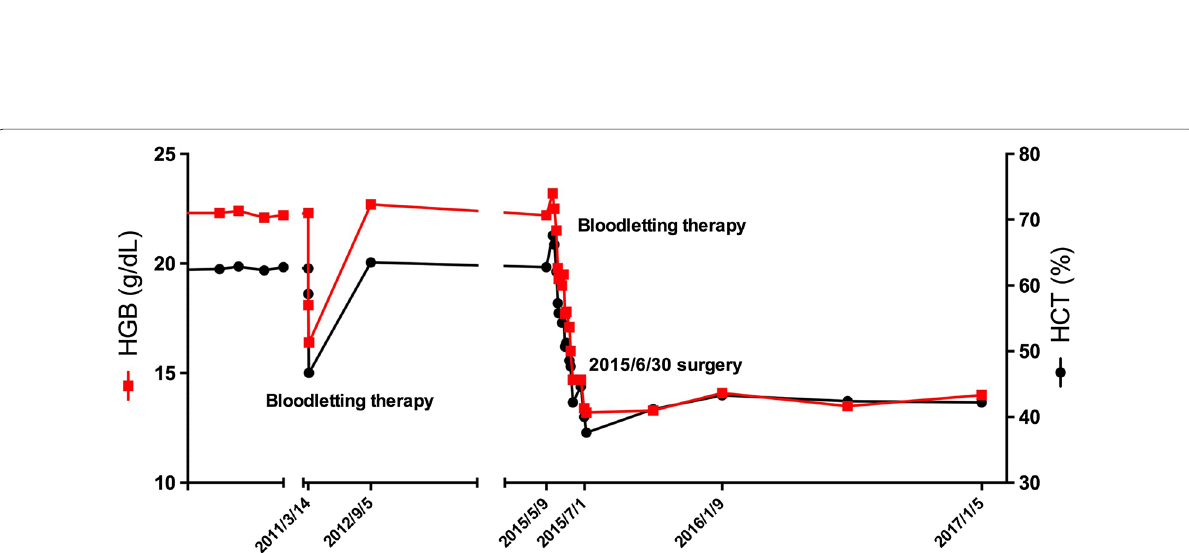
Fig. 5 Changes in the patient’s serum hemoglobin (HGB) and hematocrit (HCT) levels before and after surgery. The patient’s HGB and HCT remained at high levels before the surgery, and he was treated with intermittent bloodletting therapies at the local hospital for 9 years. One of the bloodletting therapies was taken on March 14, 2011, and his HGB and HCT declined after the bloodletting therapy. During the time of the two breaks on the horizontal axis, the bloodletting therapy and blood examination was continued, however it was not recorded. His HGB and HCT were controlled within normal levels with bloodletting therapy before surgery at QiLu Hospital. After being discharged from QiLu hospital, the patient’s HGB and HCT levels remained normal without any adjuvant therapy during the 18 months of